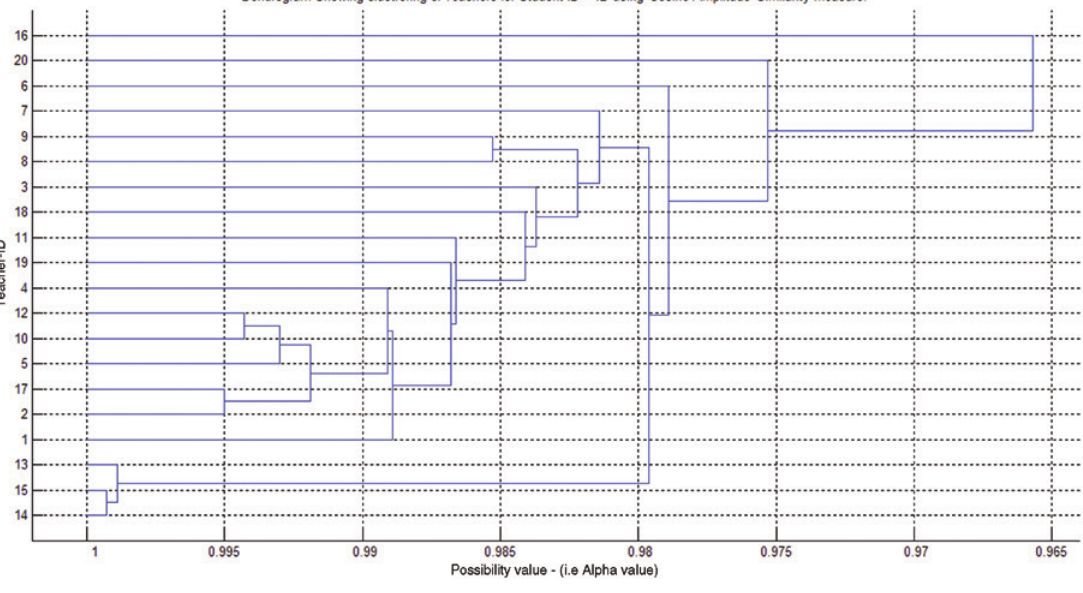
Figure 1: Dendrogram on Fuzzy Equivalence Relation the Cosine-Amplitude Method.